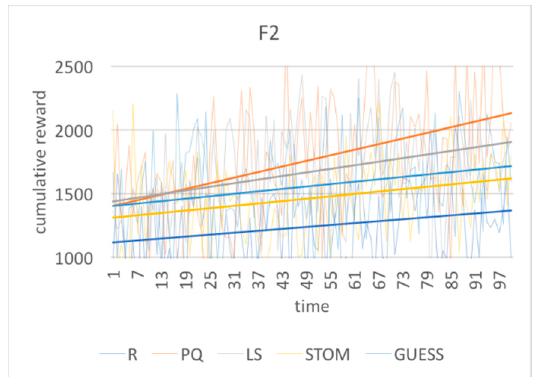
Figure 4. Cumulative reward over time for f (2) .